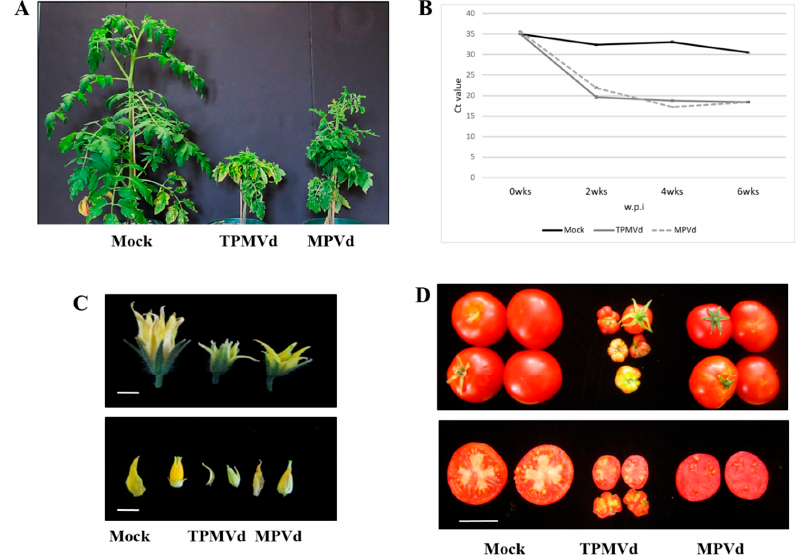
Figure 1. Phenotypes of mock-inoculated and viroid-infected Rutgers tomato plants. ( A ) Tomato plants displaying symptoms of TPMVd and MPVd infection six weeks’ post-inoculation compared to mock-inoculated plants. ( B ) Time course comparison of TPMVd and MPVd-infected vs. mock- inoculated tomato plants. Quantitative reverse transcription-polymerase chain reaction (qRT-PCR) detection (Ct values) using pospiviroid primers during three infection stages as described in Material and Methods. Early infection, 1-2 wpi, middle infection at 4 wpi, and late infection at 6 wpi. ( C ) Comparative size of flowers from mock-inoculated, TPMVd-, and MPVd-inoculated tomato plants (upper) and sepals and carpels dissected from the flowers (lower). Bars = 1 cm. ( D ) Mature fruits of mock-inoculated plants compared to plants inoculated with TPMVd and MPVd (upper) and cross-sections of mature fruits showing reduced locule number and numbers of seeds in viroid-infected versus mock-inoculated fruit (lower). Bar = 6